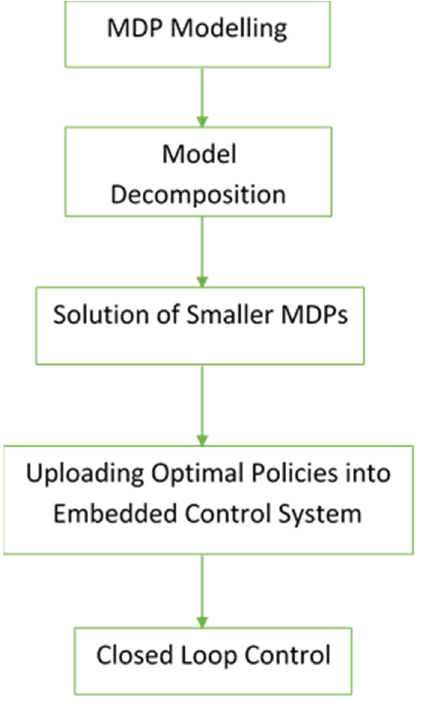
Figure 5. Flow chart.